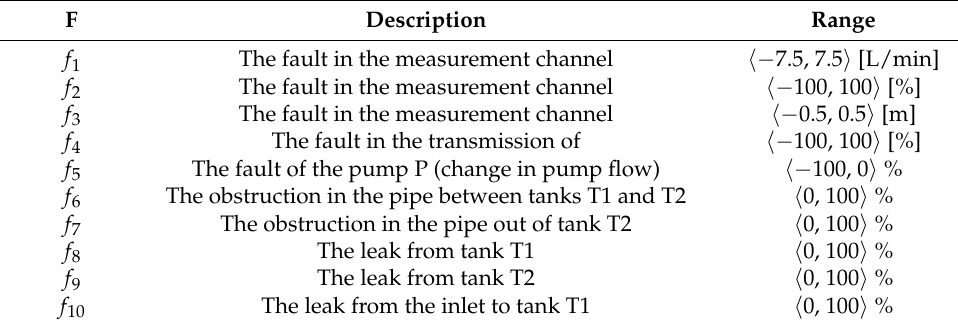
Table 2. The set of process faults in configuration for two tanks operation. F